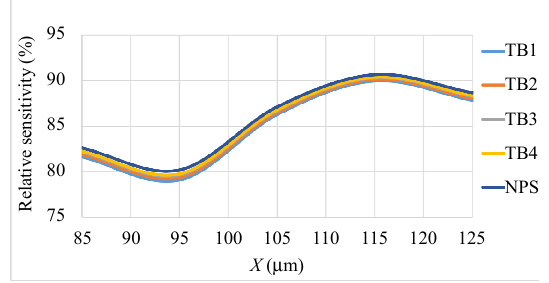
Fig. 7 RS of the proposed sensor for various tuberculosis-infected samples versus X at 2.2